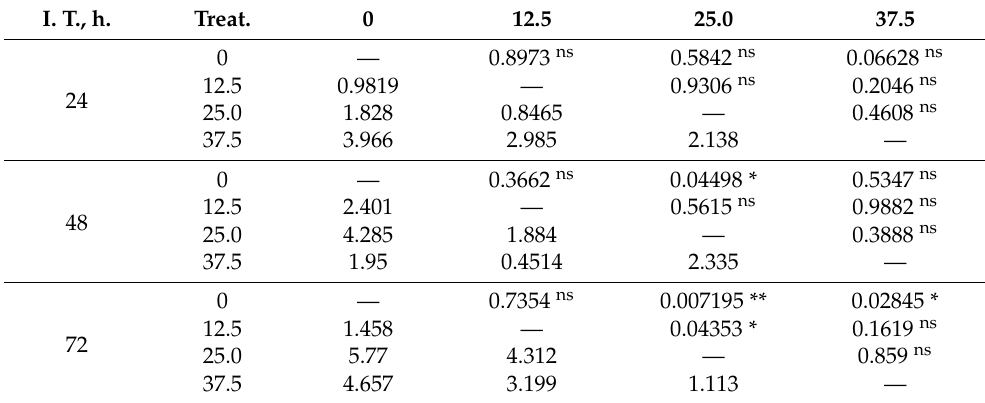
Table 5. Comparison of means of germination rate (GR) with 24, 48, and 72 h of immersion in Biozyme ® TS (gibberellins), according to Tukey HSD.